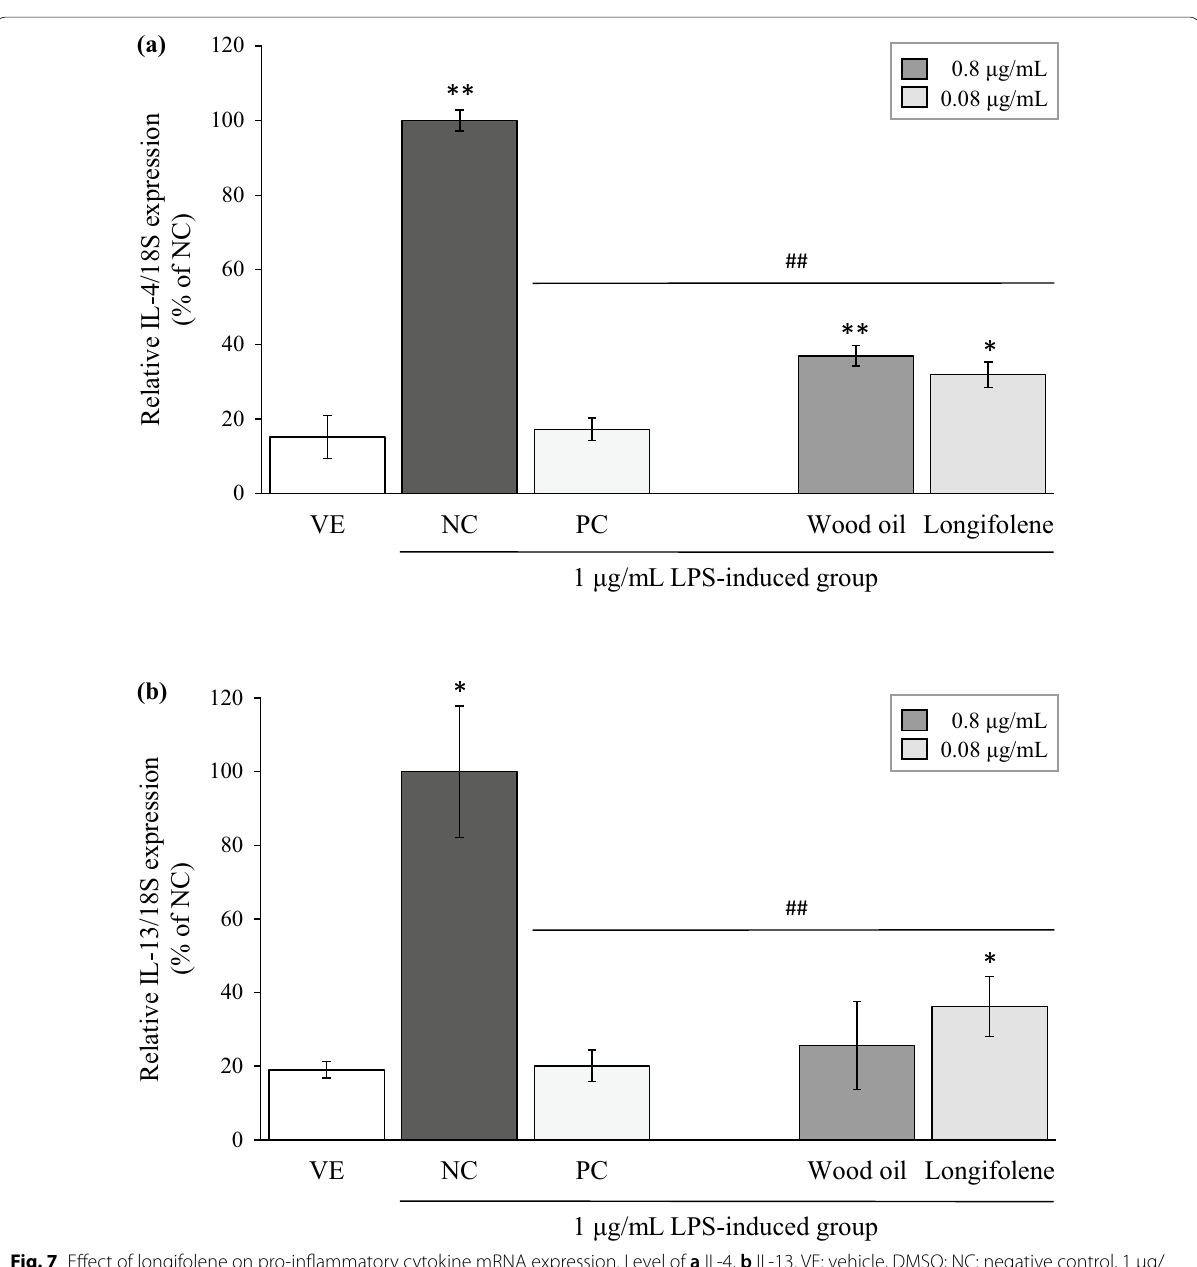
Fig. 7 Effect of longifolene on pro‑inflammatory cytokine mRNA expression. Level of a IL‑4, b IL‑13. VE: vehicle, DMSO; NC: negative control, 1 μg/ mL LPS‑treated group; PC: positive control, 100 nM dexamethasone treated group, an oil (0.8 μg/mL) and longifolene (0.08 μg/mL). Values are presented as mean standard deviation. * p < 0.05 and ** p < 0.01 compared with VE; and ## p < 0.01 compared with ±